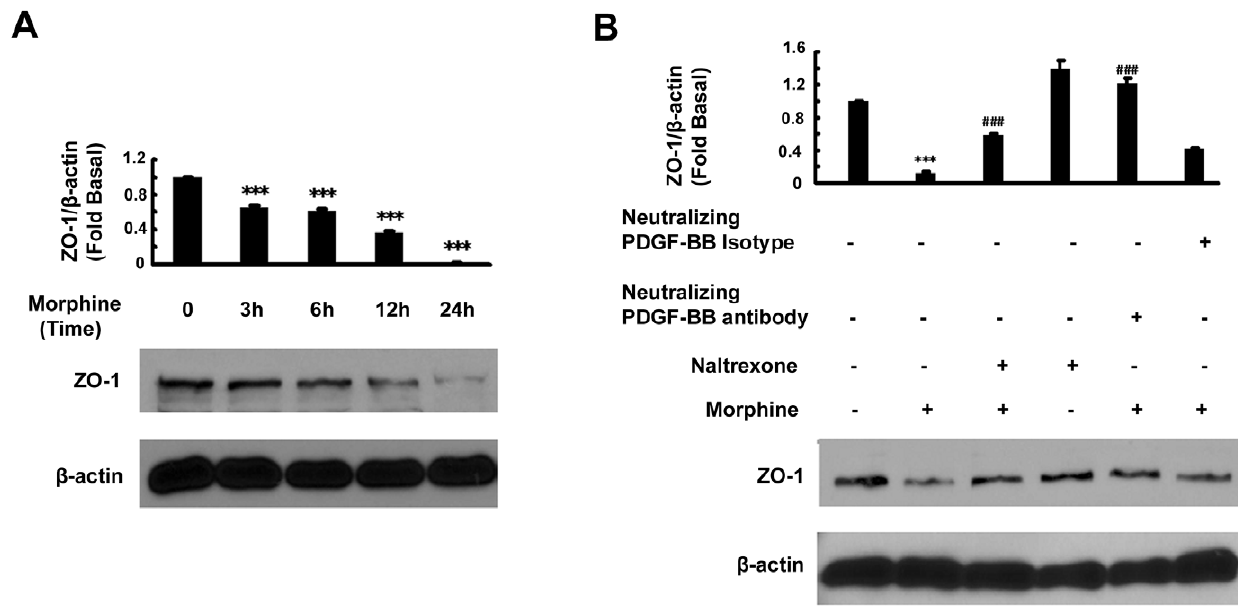
Figure 5. PDGF-BB induces down regulation of ZO-1 in HBMECs. ( A ) Time-dependent reduction of ZO-1 protein expression by morphine in HBMECs. ( B ) Treatment of cells with either the opioid receptor antagonist (naltrexone) or PDGF-BB neutralizing antibody results in inhibition of ZO-1 expression. All the data are presented as mean 6 SD of at least three individual experiments. ***p , 0.001 vs control group; ### p , 0.001 vs morphine-treated group.